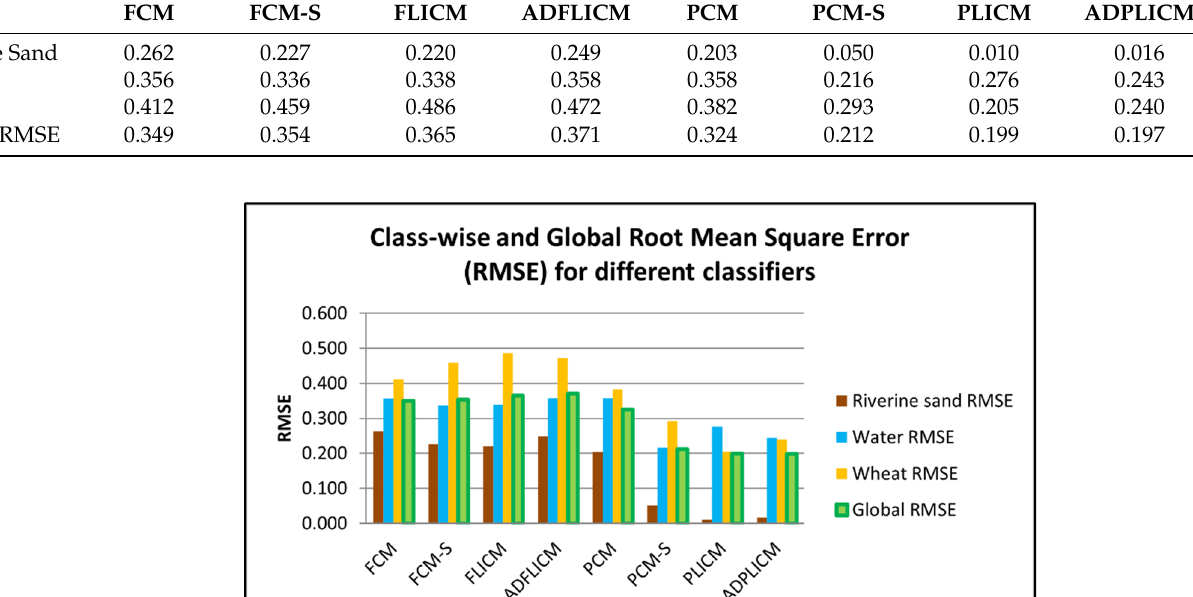
Table 4. RMSE values estimated on the outputs of different classifiers when supervised classification was applied in the presence of untrained classes.